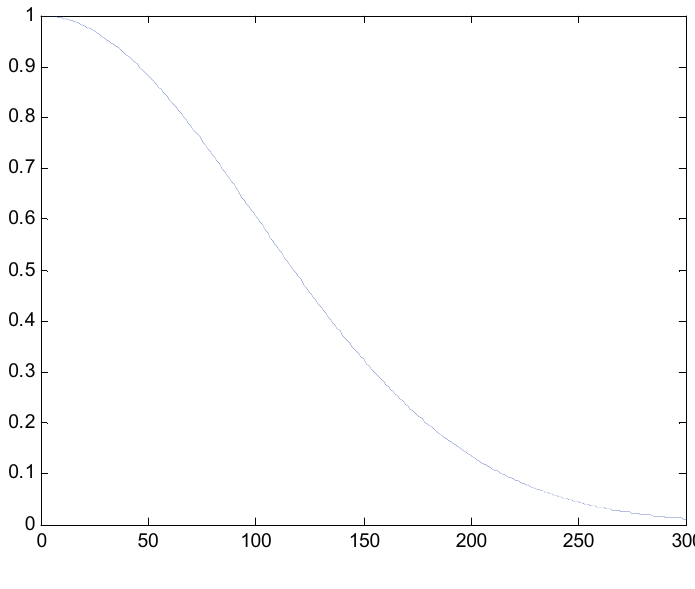
Figure 2. Curve of regulating